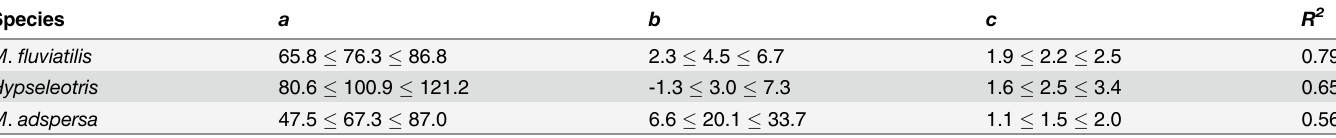
Table 2. Key statistics associated with the gross cost of transport